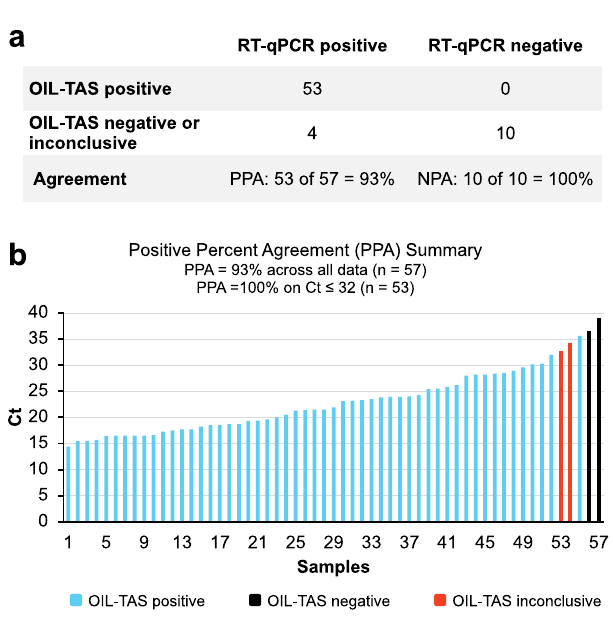
Fig. 5 Clinical sample assay performance of OIL-TAS compared to RT- qPCR. a A total of 67 clinical NP swab samples (57 positive and 10 negative for SARS-CoV-2 determined by RT-qPCR) were tested using the OIL-TAS assay ( n = 3). PPA positive percent agreement, NPA negative percent agreement. b Summary of PPA with RT-qPCR Ct values across 57 SARS-CoV- 2 positive samples. Out of the 57 PCR-positive samples, 53 tested positive with OIL-TAS (3/3 detected), 2 samples tested negative (0/3 detected), and 2 samples were inconclusive (1/3 detected). RT-qPCR Ct values are plotted in increasing order. Source data are provided as a Source Data fi